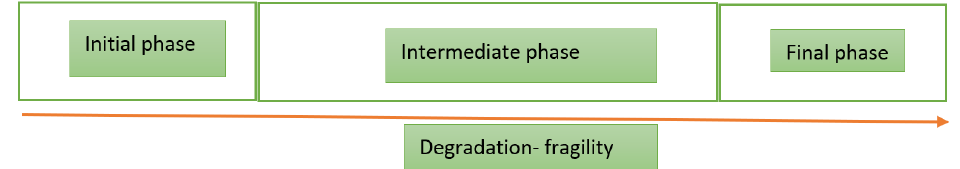
Figure 1. The stages of wood degradation-fragility from heritage objects.